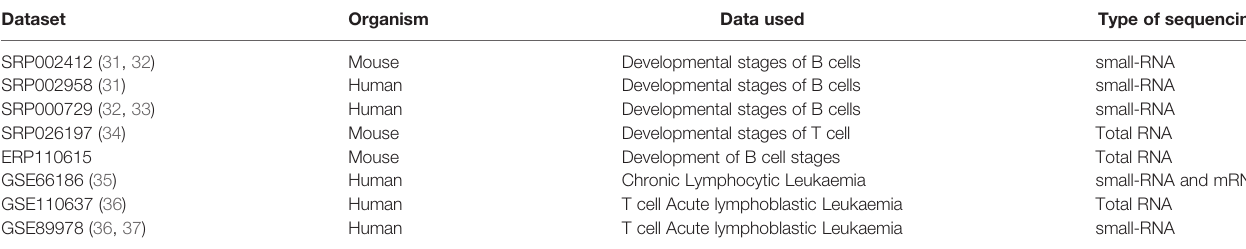
TABLE 1 | Publicly available Transcriptome Datasets from NCBI-sra used for data collection and analysis.